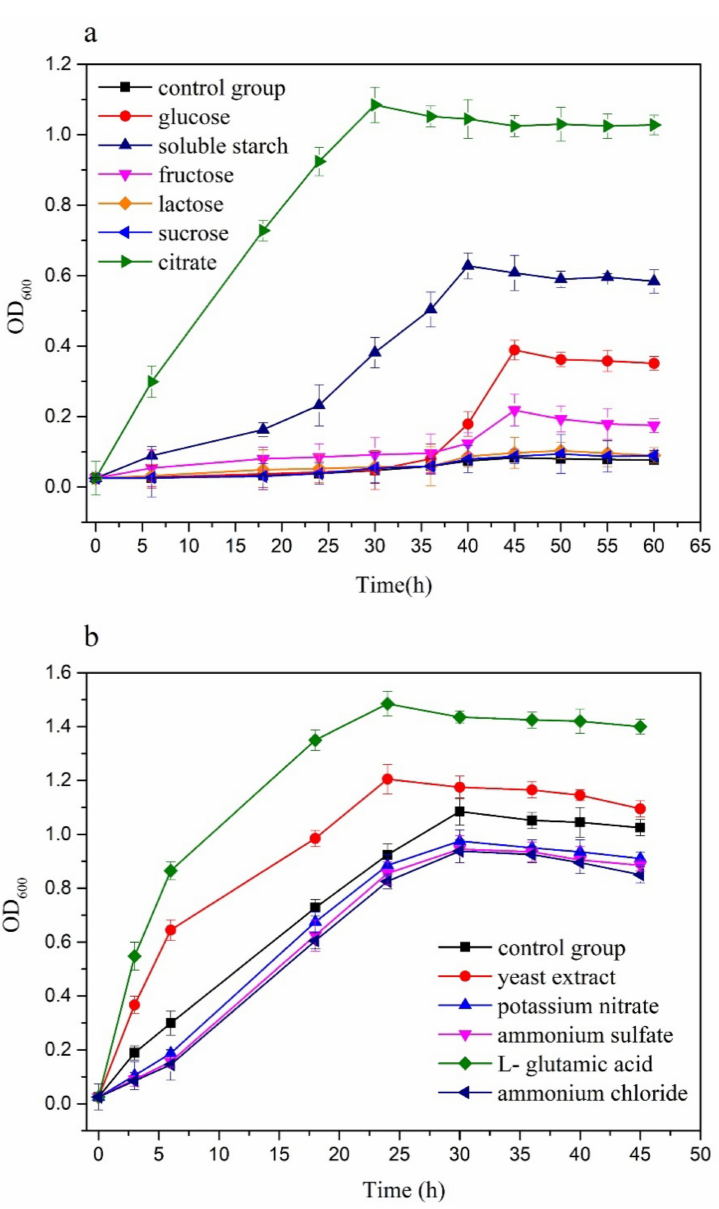
Figure 4. Growth profile of Acinetobacter sp. SCYY-5 ( a ) carbon sources, ( b ) nitrogen